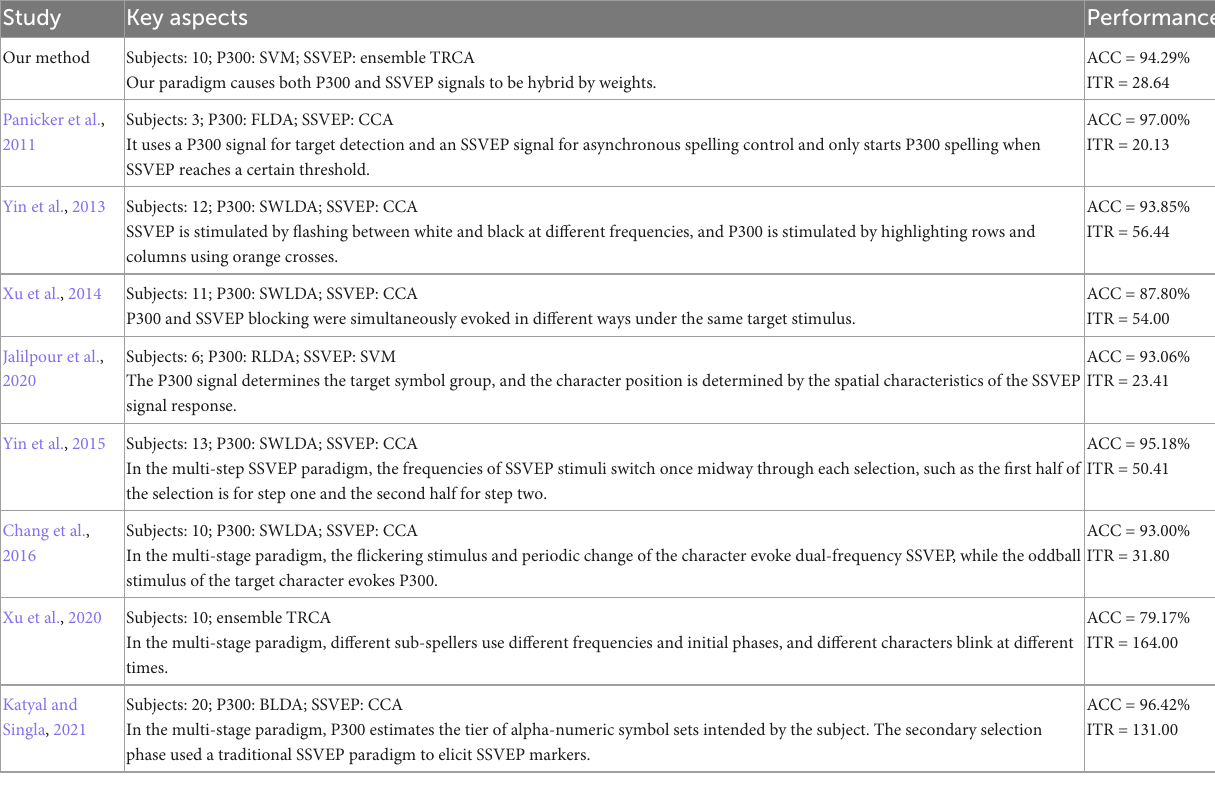
TABLE 4 Comparison of our hybrid speller to the previous